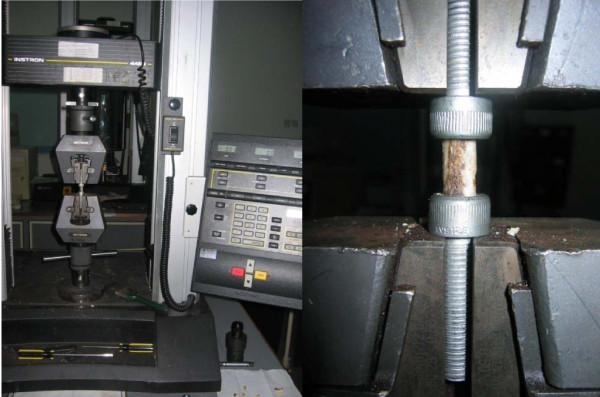
Instron machine with sample mounted on the jig.